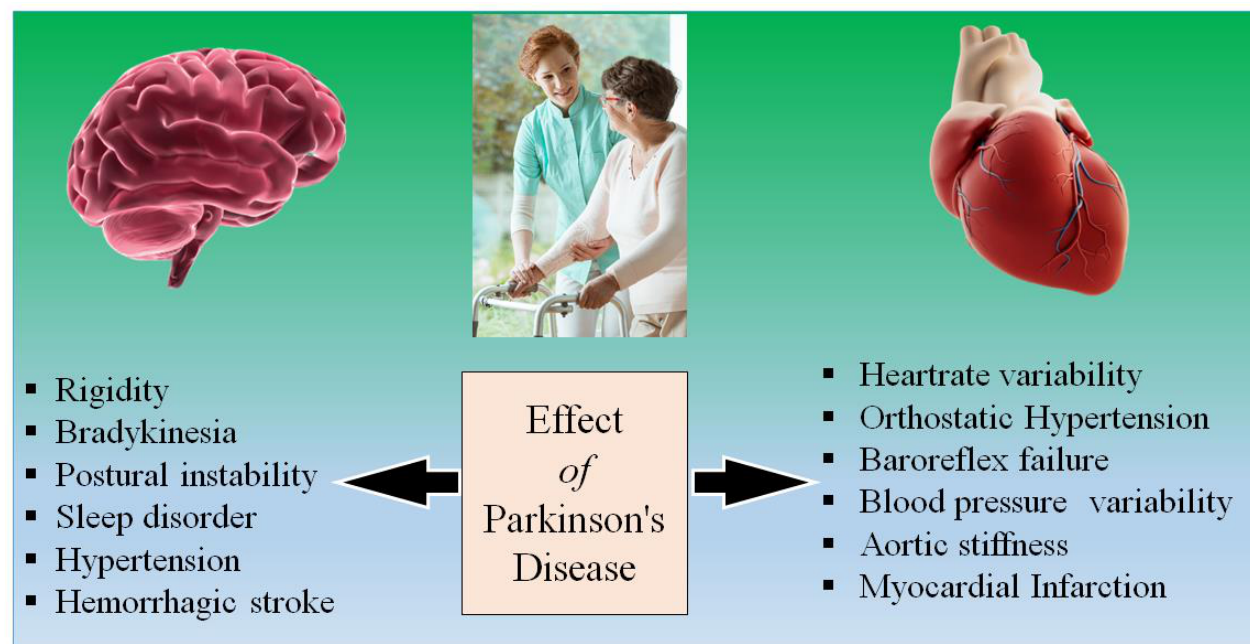
Figure 1. Long-term e ffect of Parkinson’s disease on the brain and heart.